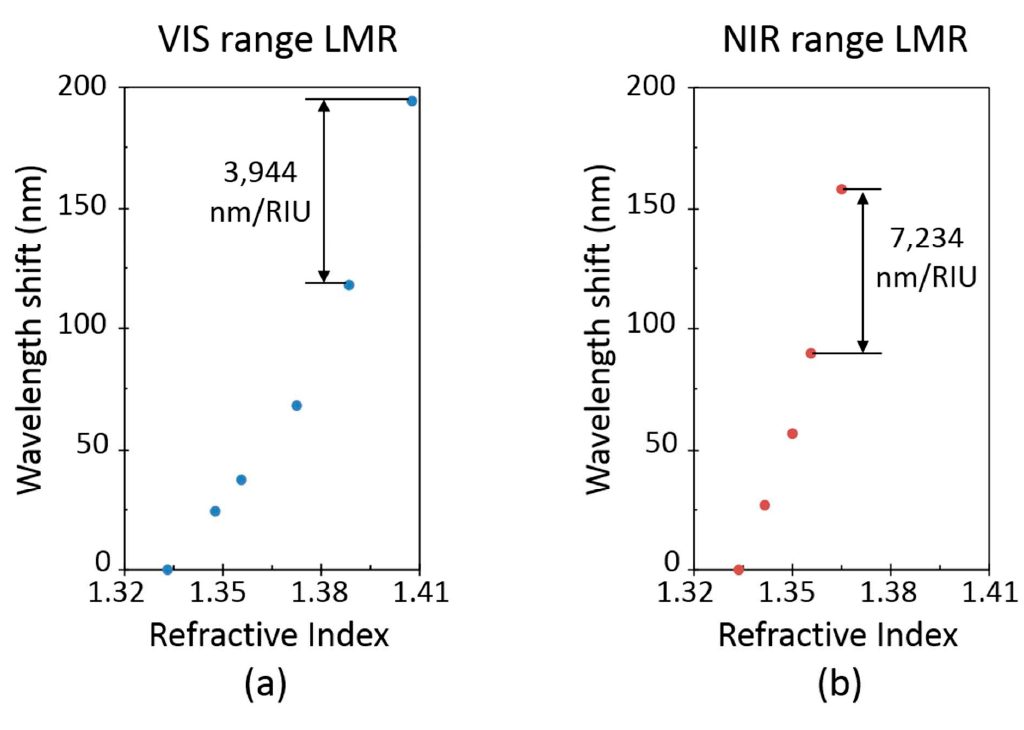
Figure 3. Wavelength shift observed in each resonance: ( a ) Shift of the LMR tuned in the VIS range (thinner CuO films). ( b ) A maximum sensitivity of 7234 nm/RIU is observed for the LMR tuned in the NIR range (thicker CuO